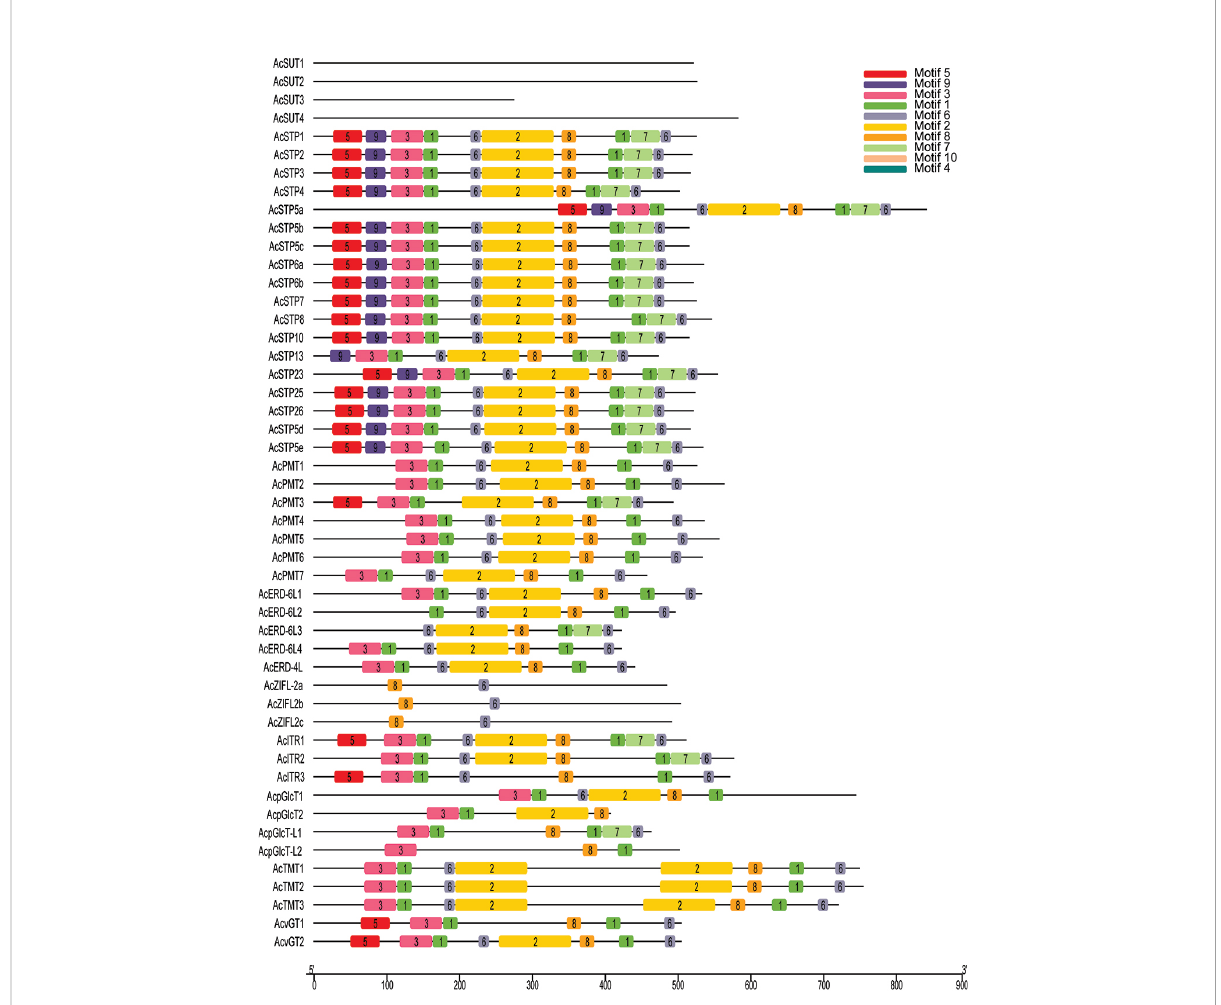
FIGURE 3 Conserved motifs and domains in sugar transporter genes of pineapple. Distribution of conserved motifs in the sugar transporter genes. The different-colored boxes represent different motifs and their position in each sugar transporter protein